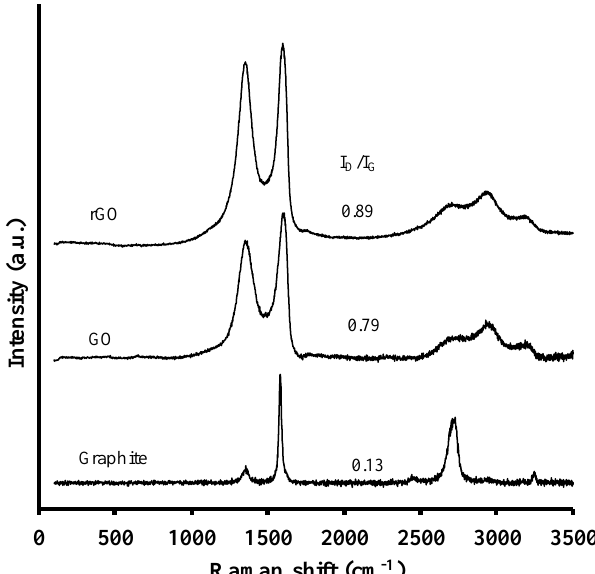
Figure 6. Raman spectra of graphite, GO, and rGO. Table 4. Parameters obtained from Raman